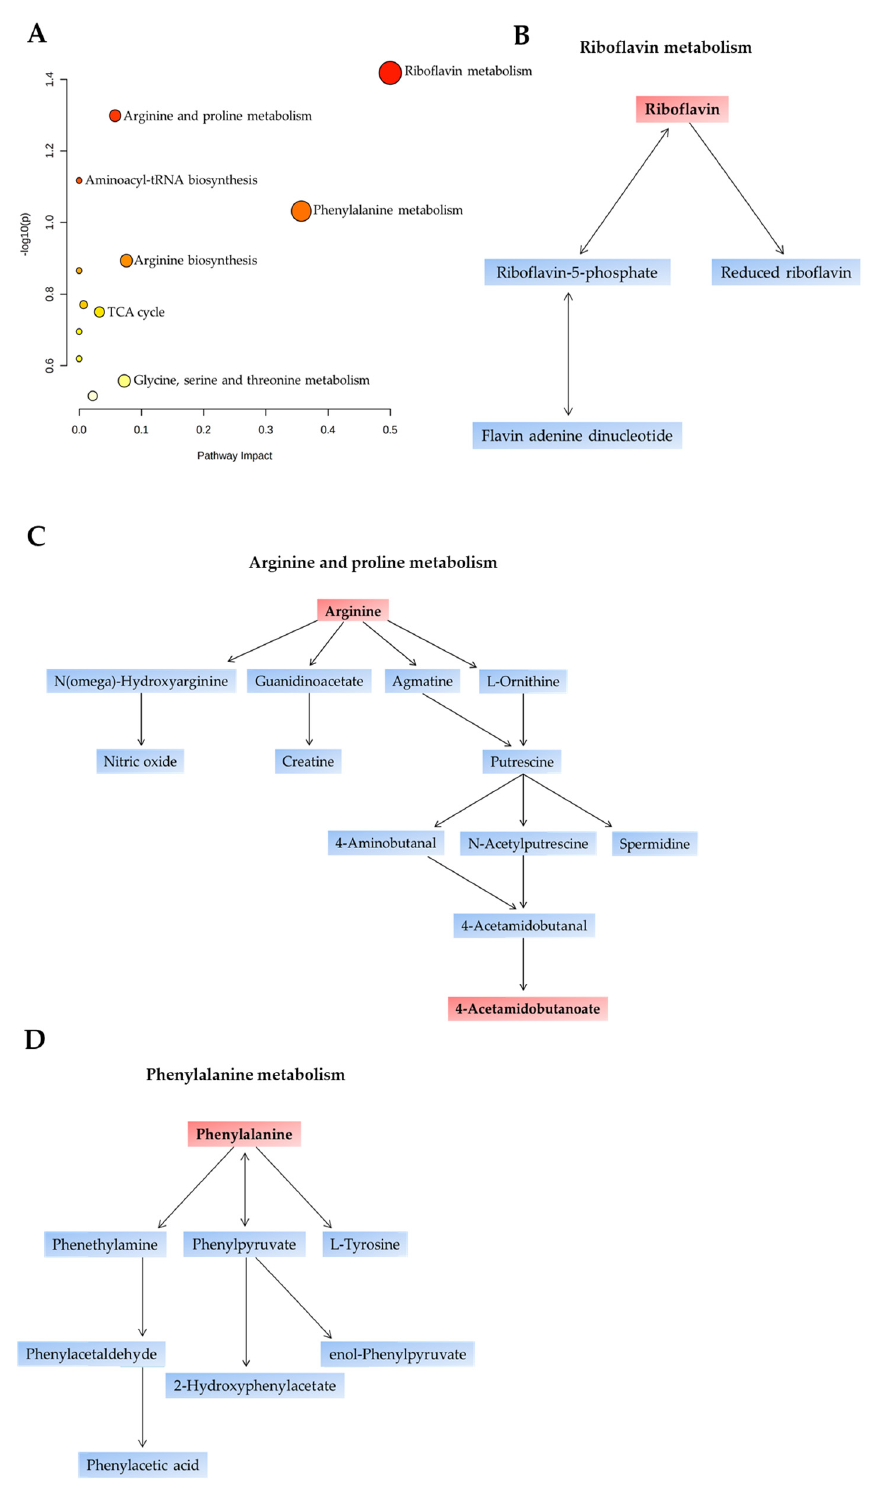
Figure 2. Primary affected metabolic pathways identified in SVNF serum samples. ( A ) The x -axis and size of circles represent impact of differential metabolites within the pathway. The y -axis and color of circles represent statistical significance of the overall metabolic changes within the pathway. ( B – D ) Schematic representation of the top three dysregulated pathways between BVNF and SVNF serum samples. ( B ) Riboflavin metabolic pathway. ( C ) Arginine and proline metabolic pathway. ( D ) Phenylalanine metabolic pathway. Metabolites highlighted in red boxes are among the 16 metabolites differentially expressed between BVNF and SVNF serum samples.